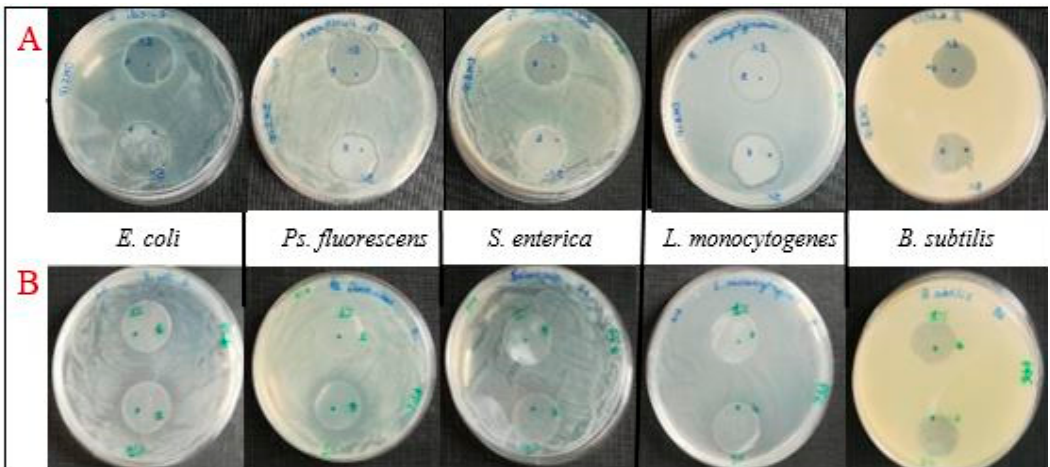
Figure 6. Images of inhibition halos induced by Pebax ® Rnew/IL1 ( A ) and Pebax ® Rnew/IL2 ( B ) blends, after 24 h of incubation on NA plates inoculated with 100 µL cell suspension at 10 6 CFU/mL concentration of E. coli , Ps. fluorescens , S. enterica , L. monocytogenes and B. subtilis .